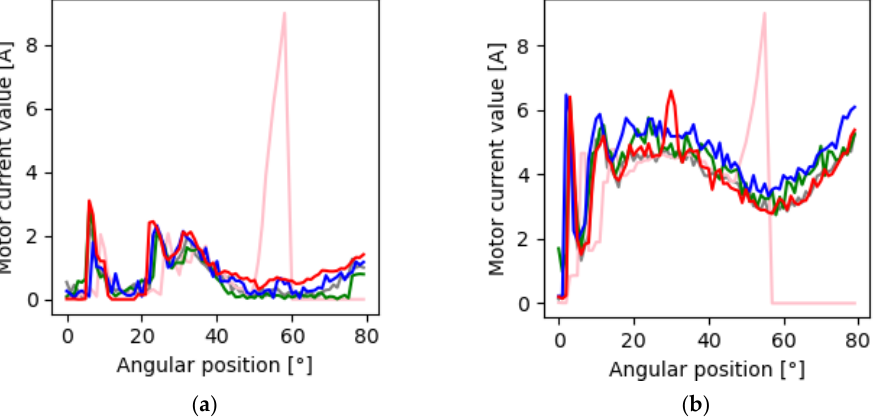
Figure 2. ( a ) Current waveforms when a barrier boom is moving down. Correct readings are marked in grey; anomalies in pink (boom has hit a solid obstacle), green (white noise), blue (gear fault), red (boom has hit a flexible obstacle); ( b ) Current waveforms when a barrier boom is going up. Correct readings are marked in grey; anomalies in pink (a serious damage), green (white noise), blue (gear fault), red (obstacle has been hit).